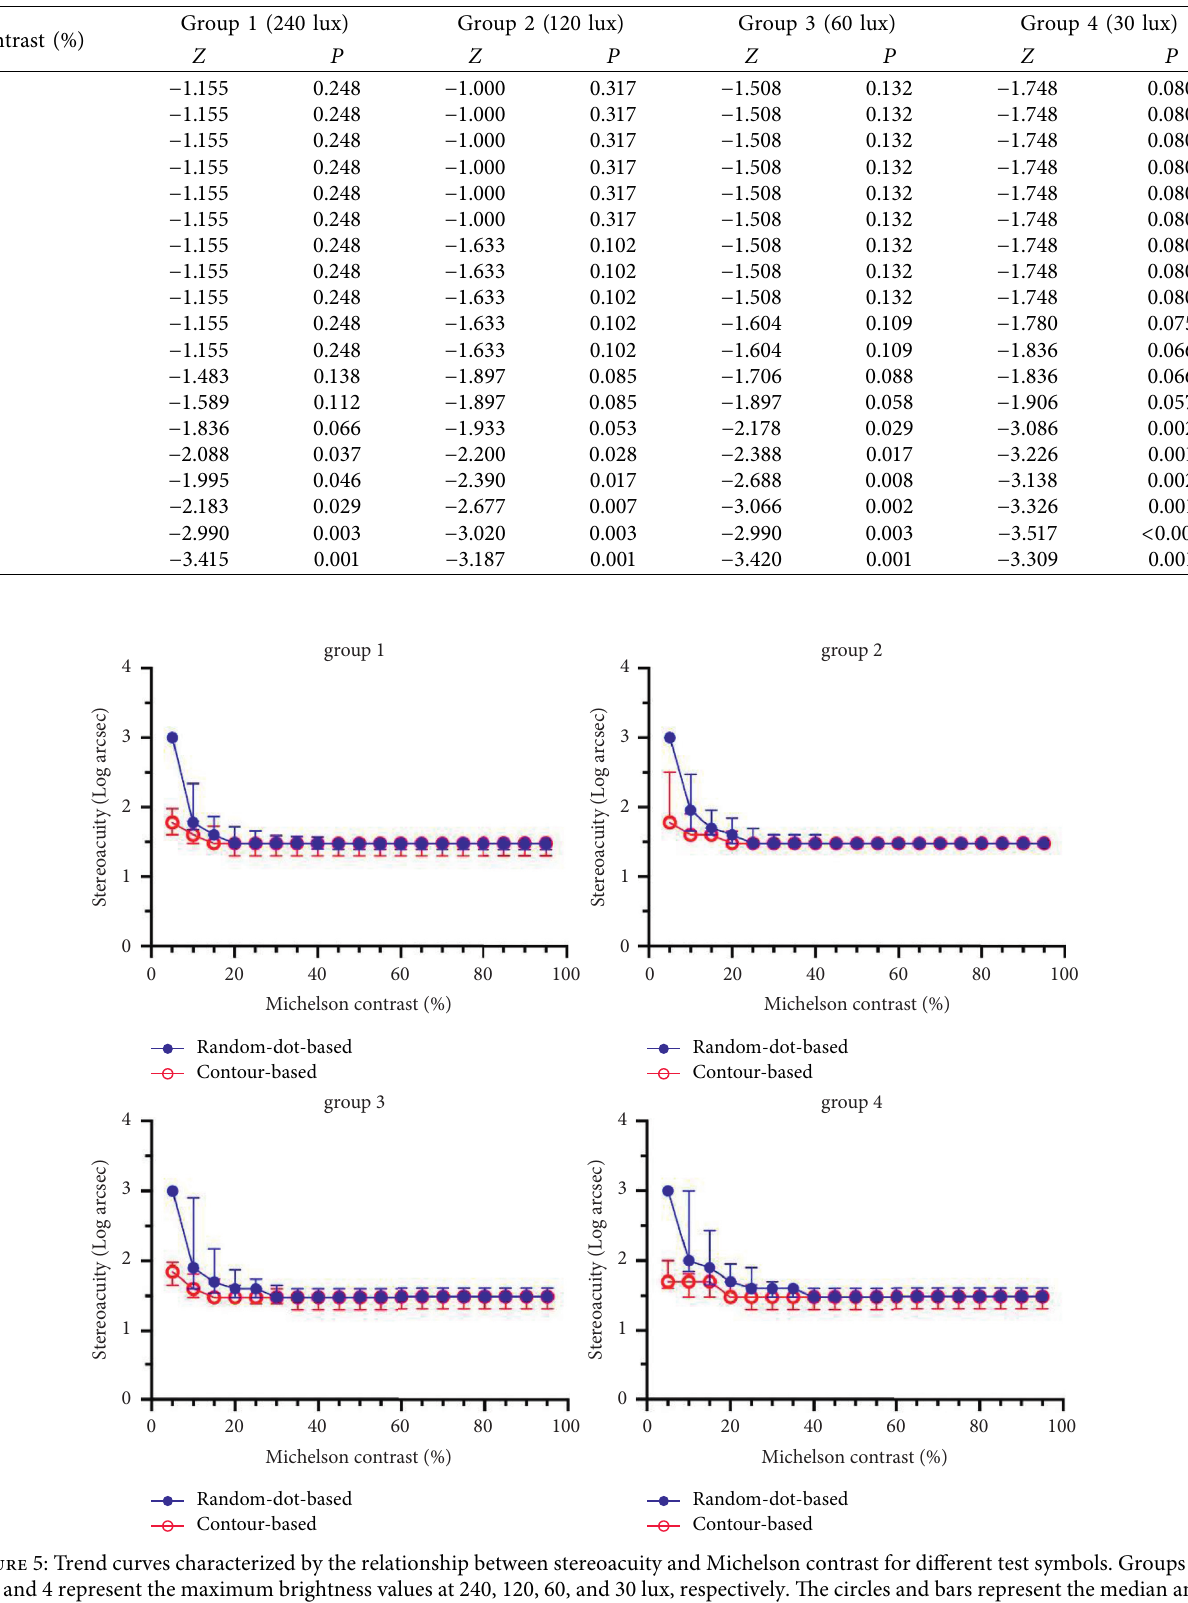
Table 2: Wilcoxon signed-rank test result between random-dot-based and contour-based measurements in different luminance groups.